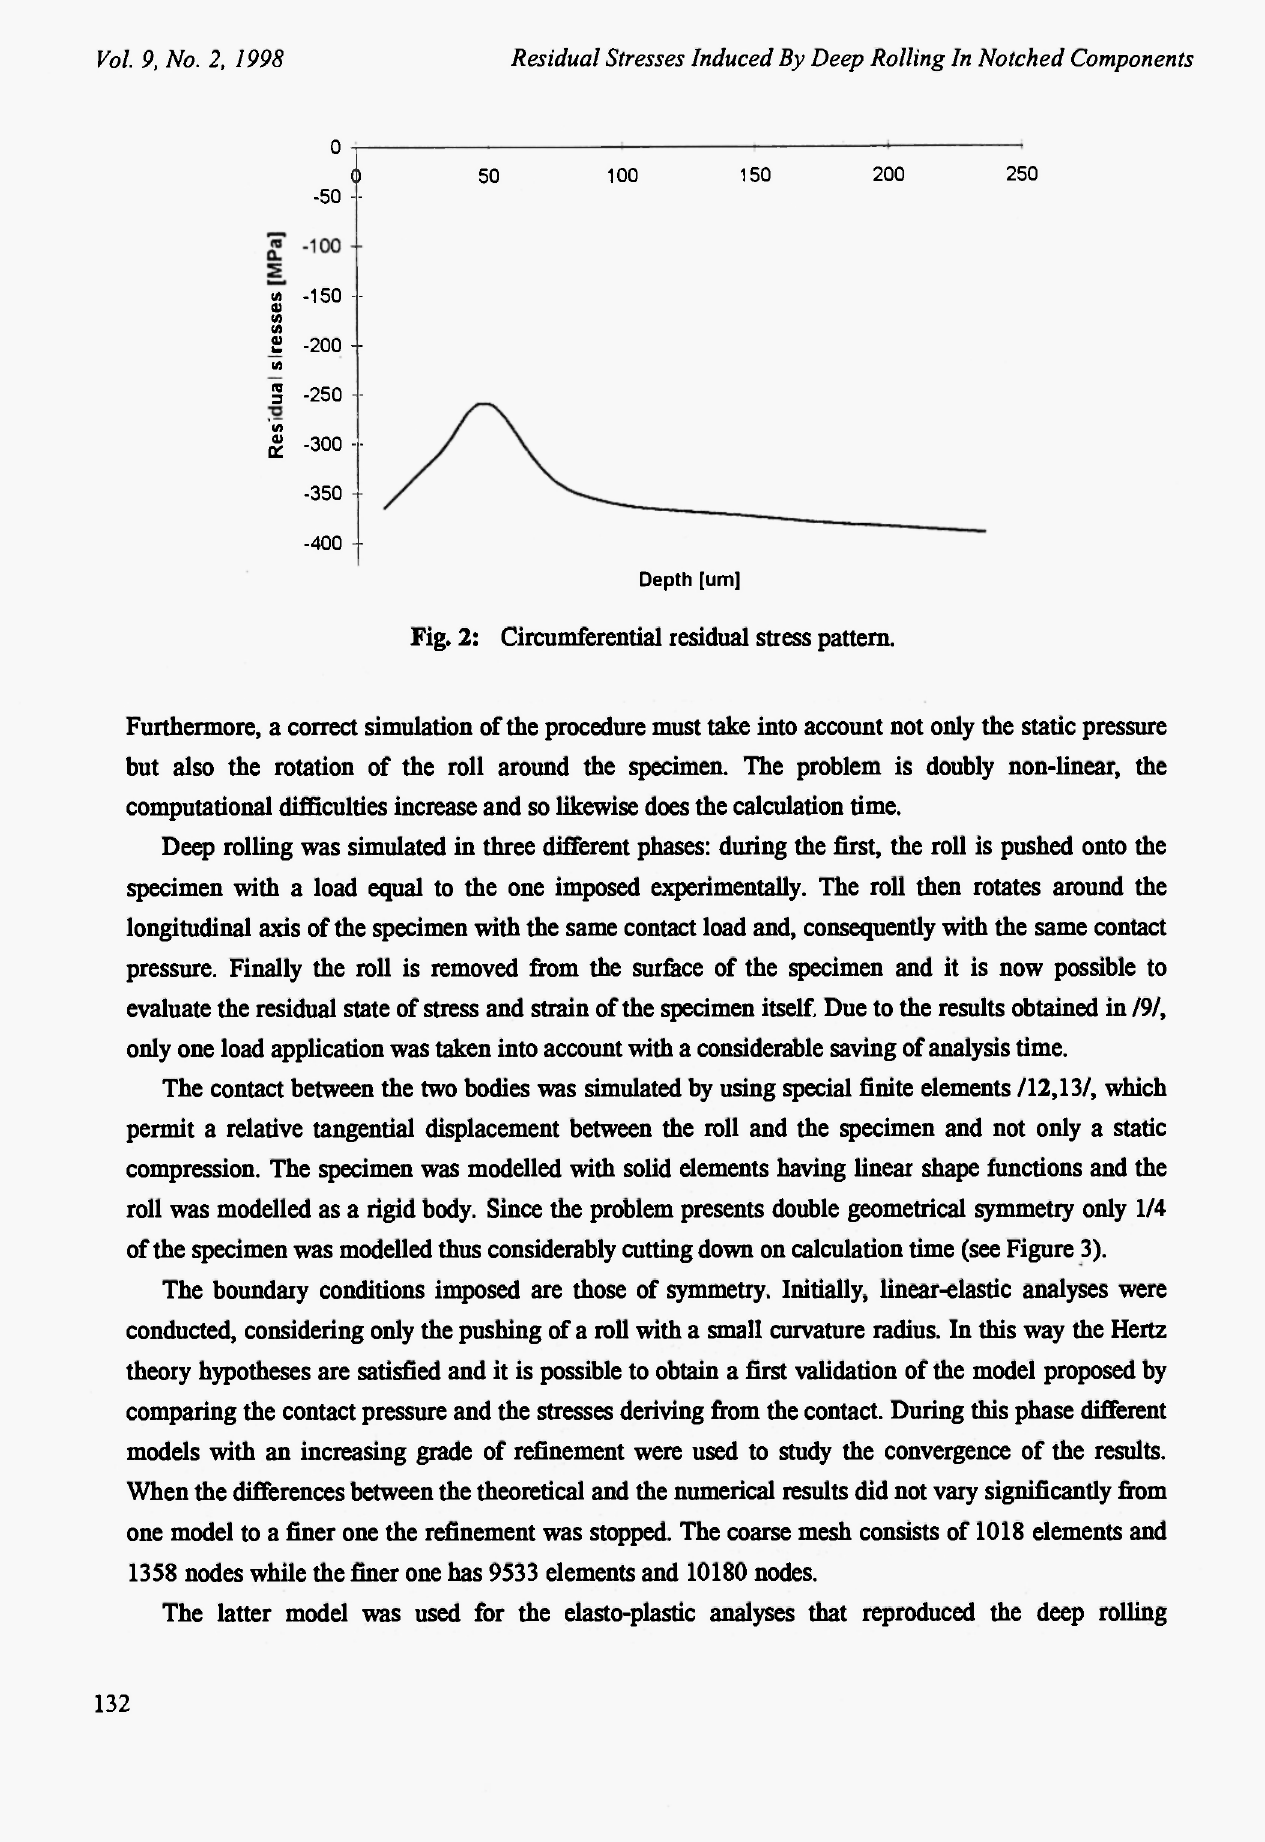
Fig. 2: Circumferential residual stress